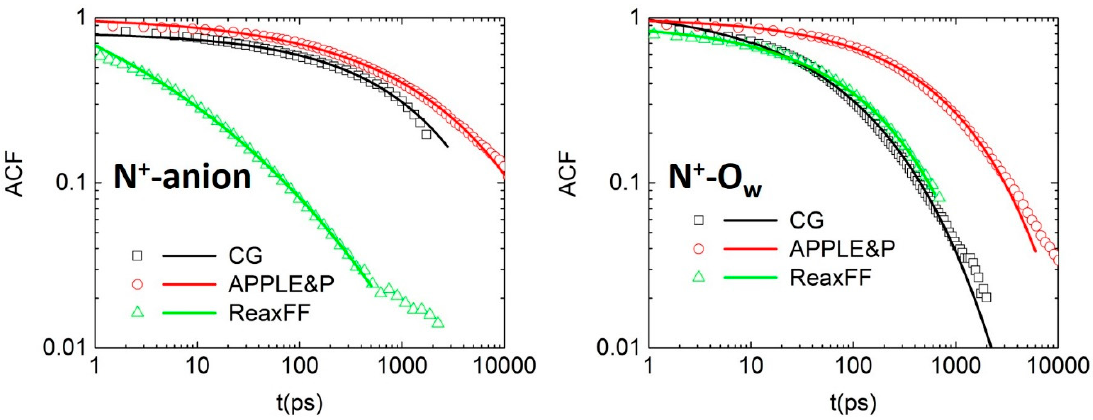
Figure 5. Autocorrelation functions (ACFs) and Kohlrausch-Williams-Watts (KWW) fits obtained from simulations using three models.